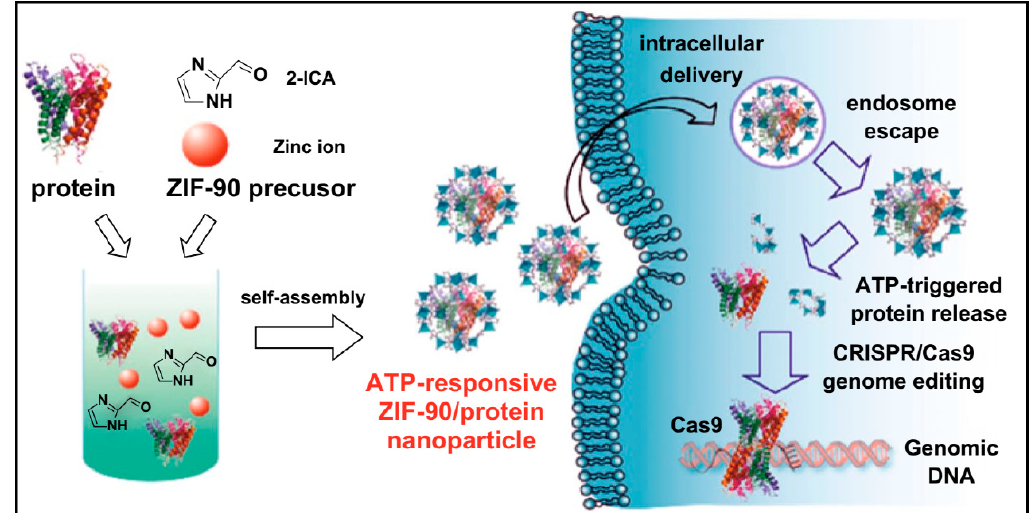
Figure 12. Examples of ATP-responsive chemically modified BioMOF nanostructures: ZIF-90/protein NPs. Reproduced with permission from Ref. [205]. Copyright © 2019, American Chemical Society.